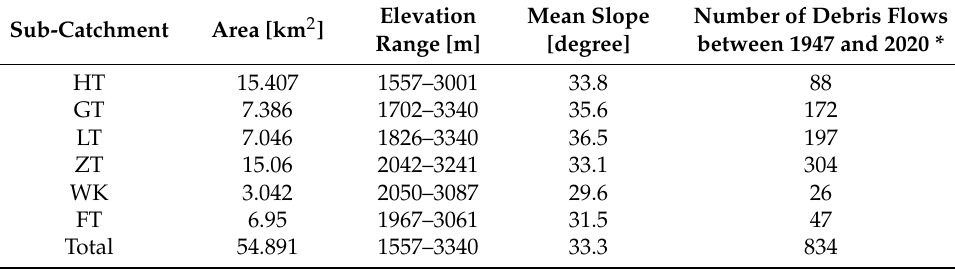
Figure 2. Technical roadmap of the study.